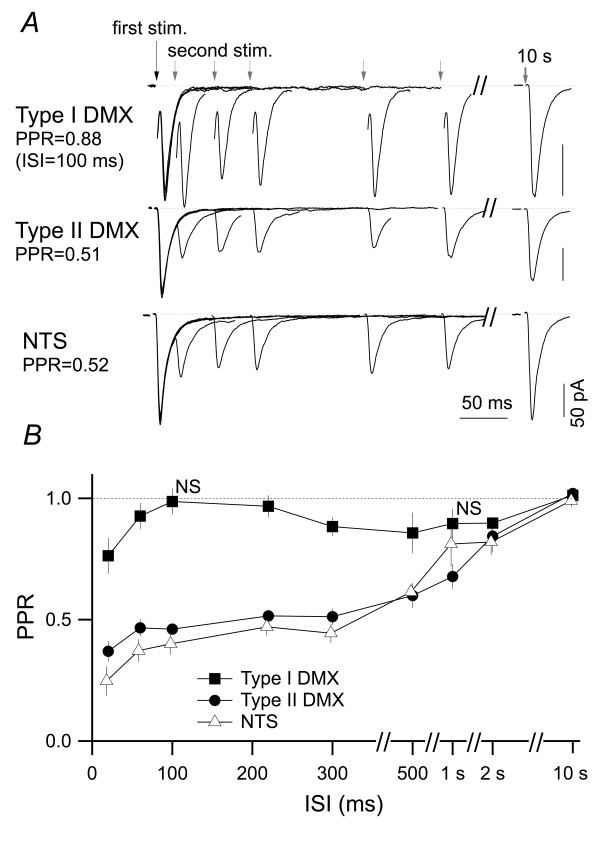
Dependence of paired-pulse ratio of EPSC amplitude on interstimulus time intervals. A, representative EPSC traces from type I DMX (top), type II DMX (middle) and dm-cNTS (NTS; bottom) neurons evoked by successive stimuli that were delivered at inter-stimulus intervals of 20, 60, 100, 220, 300 ms and 10 s. Seven traces are overlaid and aligned at the first EPSC waveform (long arrow at the left) for each neuron. Each trace is an average of 8 responses. B, summary of the paired-pulse ratio at different ISIs. Mean and SEM of the PPR values measured in type I (n = 4-19) and type II (n = 3-13) DMX neurons and dm-cNTS neurons (n = 4-9). Note that the ISI-dependence of PPR values also differed among these three neuron groups. The PPR values at each ISI were statistically compared to those at ISI of 10 s in each neuron group. At all time points, the PPR was significantly smaller (ANOVA; P < 0.05), except at 100 ms and 1 s for type I DMX neurons, at which the PPR was not significantly different from that at 10 s.